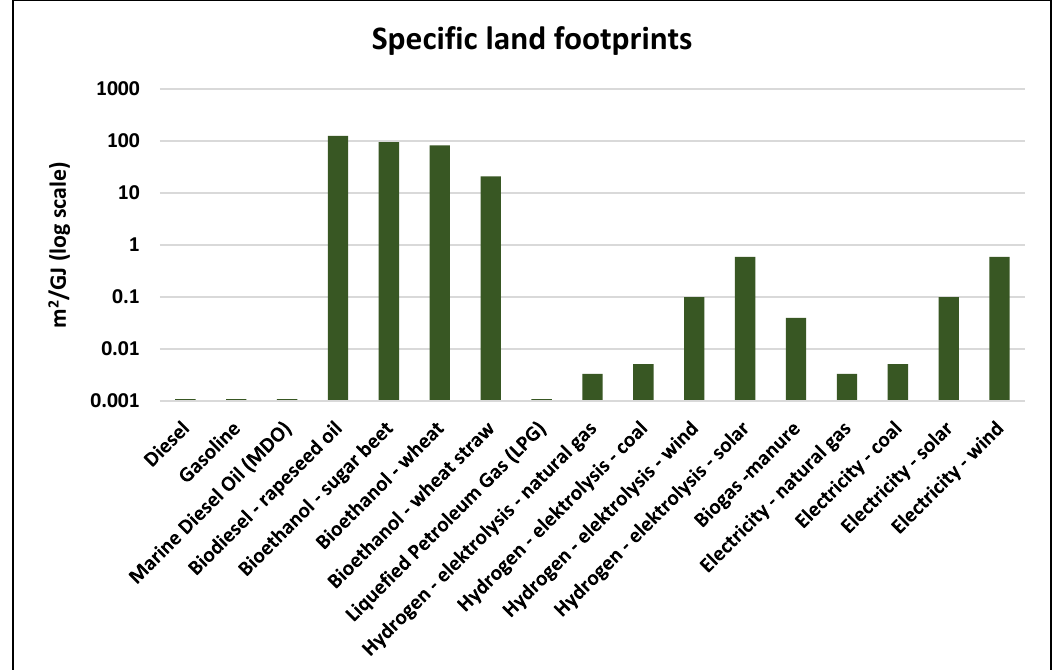
Figure 3. Land footprints per fuel and according to primary energy source (m 2 /GJ, logarithmic scale). The differences between the land footprints (LFs) are larger in comparison to the carbon footprints (CFs). In particular, fuels derived from agriculture have large LFs. Bioethanol from wheat, for example, requires a factor 10,000 more land per unit of energy than diesel (from crude oil). Fossil fuels have the smallest LFs, while the LFs of wind and solar energy find themselves in between the two extremes. Appendix B gives the specific land footprints. Figure 4 shows the specific water footprints per fuel and related primary energy source on a logarithmic scale (m 3 /GJ).